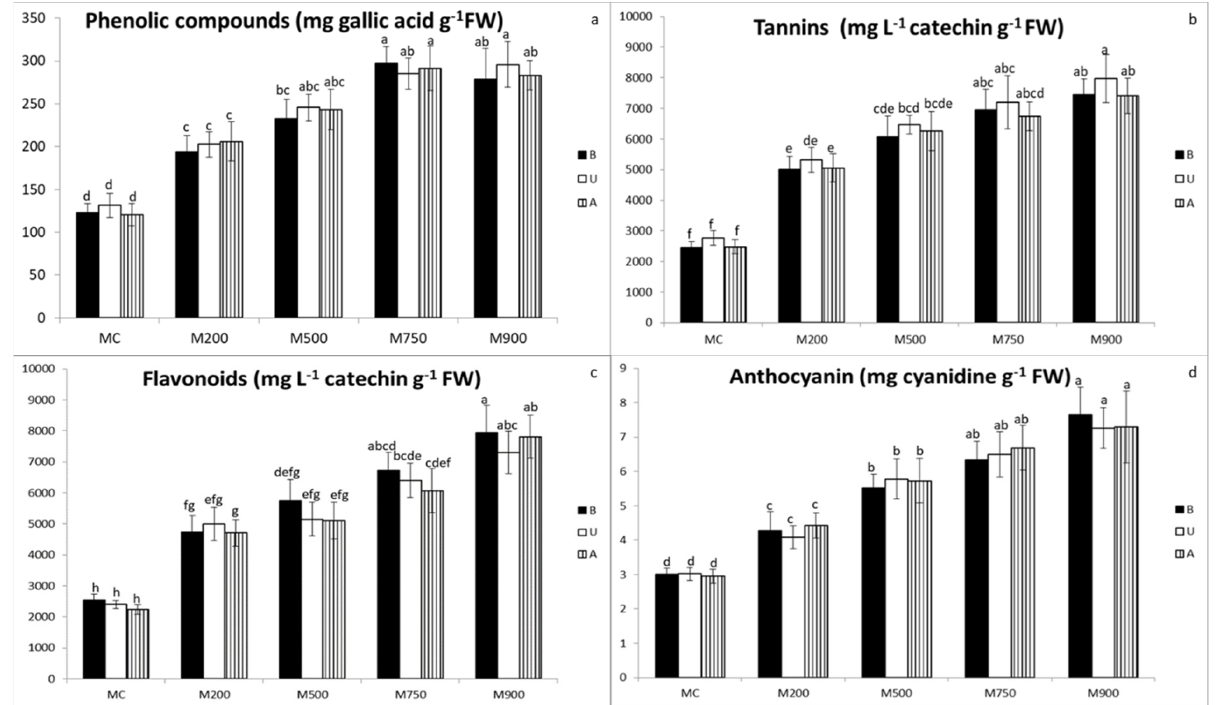
Figure 3. Phenolic compounds ( a ), tannin ( b ), flavonoid ( c ), and anthocyanin ( d ) concentrations in the leaves of three different miscanthus cultivars (B, U, and A) cultivated in soils with gradient TE concentrations (MC, M200, M500, M750, and M900). Values are presented as means ± SD. Different letters refer to significant differences between plants (Turkey HSD test, n = 5, p ≤ 0.05). Phenolic compounds levels gradually increased from 122.8, 131.3, and 120.8 mg gallic acid g − 1 FW, corresponding in the leaves B, U, and A plants cultivated in the MC soil, to 297.0, 295.9, and 291.3 3 mg gallic acid g − 1 FW, corresponding to B, U, and A cultivated in the M750. M900 and M750 soils respectively recorded 141.8, 125.4, and 141.3% accretion compared to background